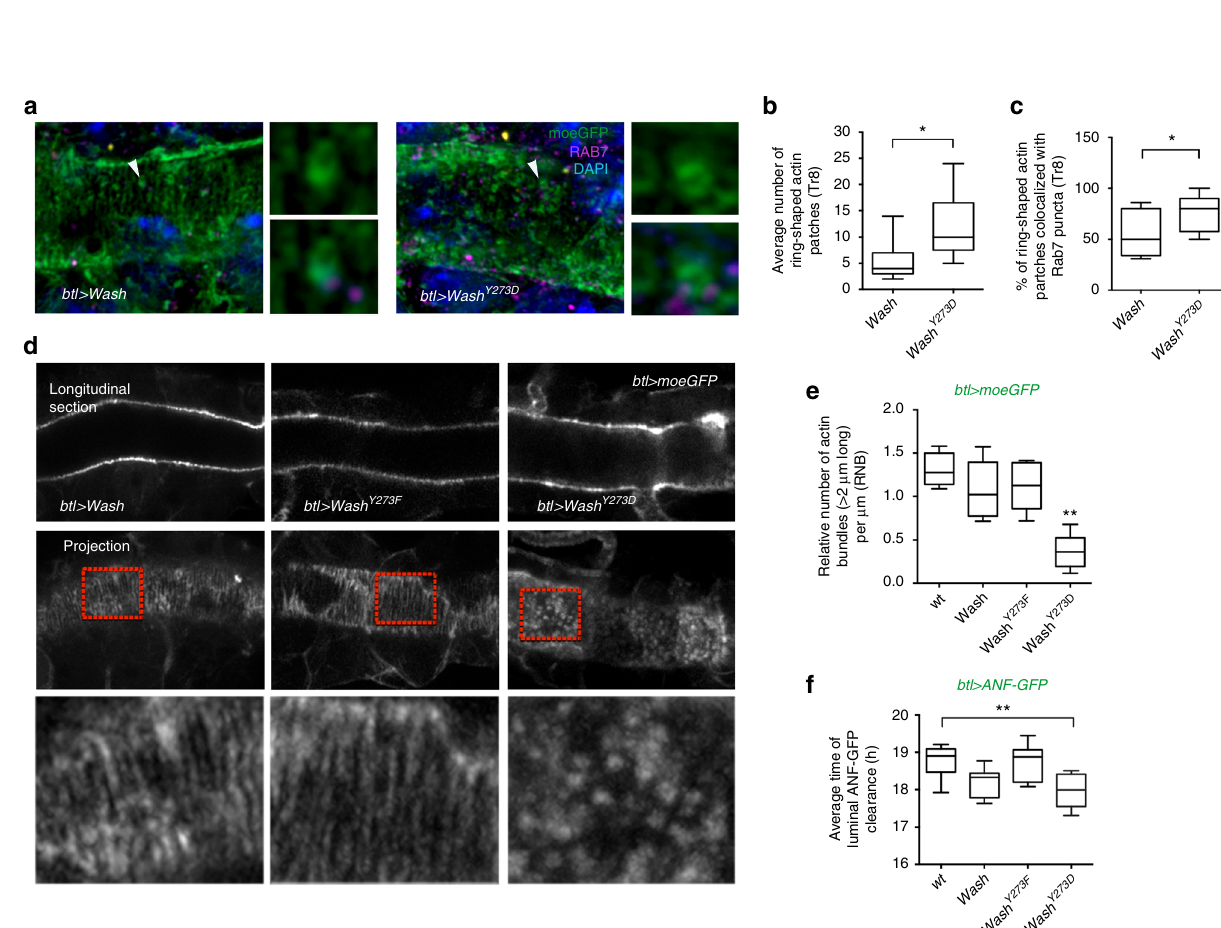
Fig. 7 Btk29A forms complexes with Ptp10D and WASH (Wiskott – Aldrich syndrome protein and SCAR homologue). a Co-immunoprecipitates of Btk29A, using anti-Btk29A antibody or IgG (negative control), from protein lysates of wild-type (w1118) or Ptp10D mutant (#5810) embryos blotted with anti- Ptp10D and anti-Btk29A. Input (3%) is indicated. b Co-immunoprecipitates of WASH, with anti-WASH antibody or IgG (negative control) from protein lysates of wild-type, 69B>Btk29A WT , 69B>Btk29A KD and wild-type embryos blotted with anti-pY, anti-Btk29A and anti-WASH. Input (3%) is indicated. c Bar graph depicting the relative pY levels of WASH immunoprecipitates shown in b . Error bars denotes s.e.m. ( n = 3, independent immunoprecipitation (IP) experiments). ** P < 0.004, ns not signi fi cant ( P > 0.05) (unpaired two tailed t tests). d Co-immunoprecipitates of HA-tagged WASH protein from lysates of transfected S2 cells (using anti-HA antibody or rabbit IgG as a control), blotted with anti-pY, anti-Btk29A and anti-WASH. The cells were transfected with pAWF vector containing Btk29A cDNA and pAHW containing Wash or Wash Y273D cDNA, as indicated. e Graph showing the relative pY intensity of the Btk29A-Flag, HA-Wash and Btk29A-Flag, HA-Wash Y273D samples shown in d . ** P < 0.0029 (unpaired two tailed t tests), n = 5 (independent IP experiments). The boxplots ( c , e ) show the median (horizontal line) and the data range from 25th to 75th percentile. Bars present maxima and minima values. f Confocal images showing staining for GFP (green), phalloidin (red) and Hoechst (blue) of WASH-knockout mouse embryonic fi broblasts (WASH KO mouse embryonic fi broblasts (MEFs)) expressing GFP-Wash , GFP-Wash Δ VCA , GFP-Wash Y261A and GFP-Wash Y261D . The two right columns display zoomed view of regions indicated by a rectangular frame in left columns. Representative images are shown. Scale bars, 10 μ m on non-zoomed and 5 μ m on zoomed images. g Scatter plots showing the normalized mean fl uorescence intensity (MFI) of F-actin on GFP-positive puncta in Wash knockout MEFs cells expressing GFP-Wash ( n = 616, puncta), GFP-Wash Δ VCA ( n = 249), GFP-Wash Y261A ( n = 199) and GFP-Wash Y261D ( n = 326). Values were normalized to the control ( GFP-Wash ). Two independent experiments from each condition are shown. Signi fi cance was calculated relative to the control ( GFP-Wash ) by unpaired two tailed t test; *** P < 0.0001